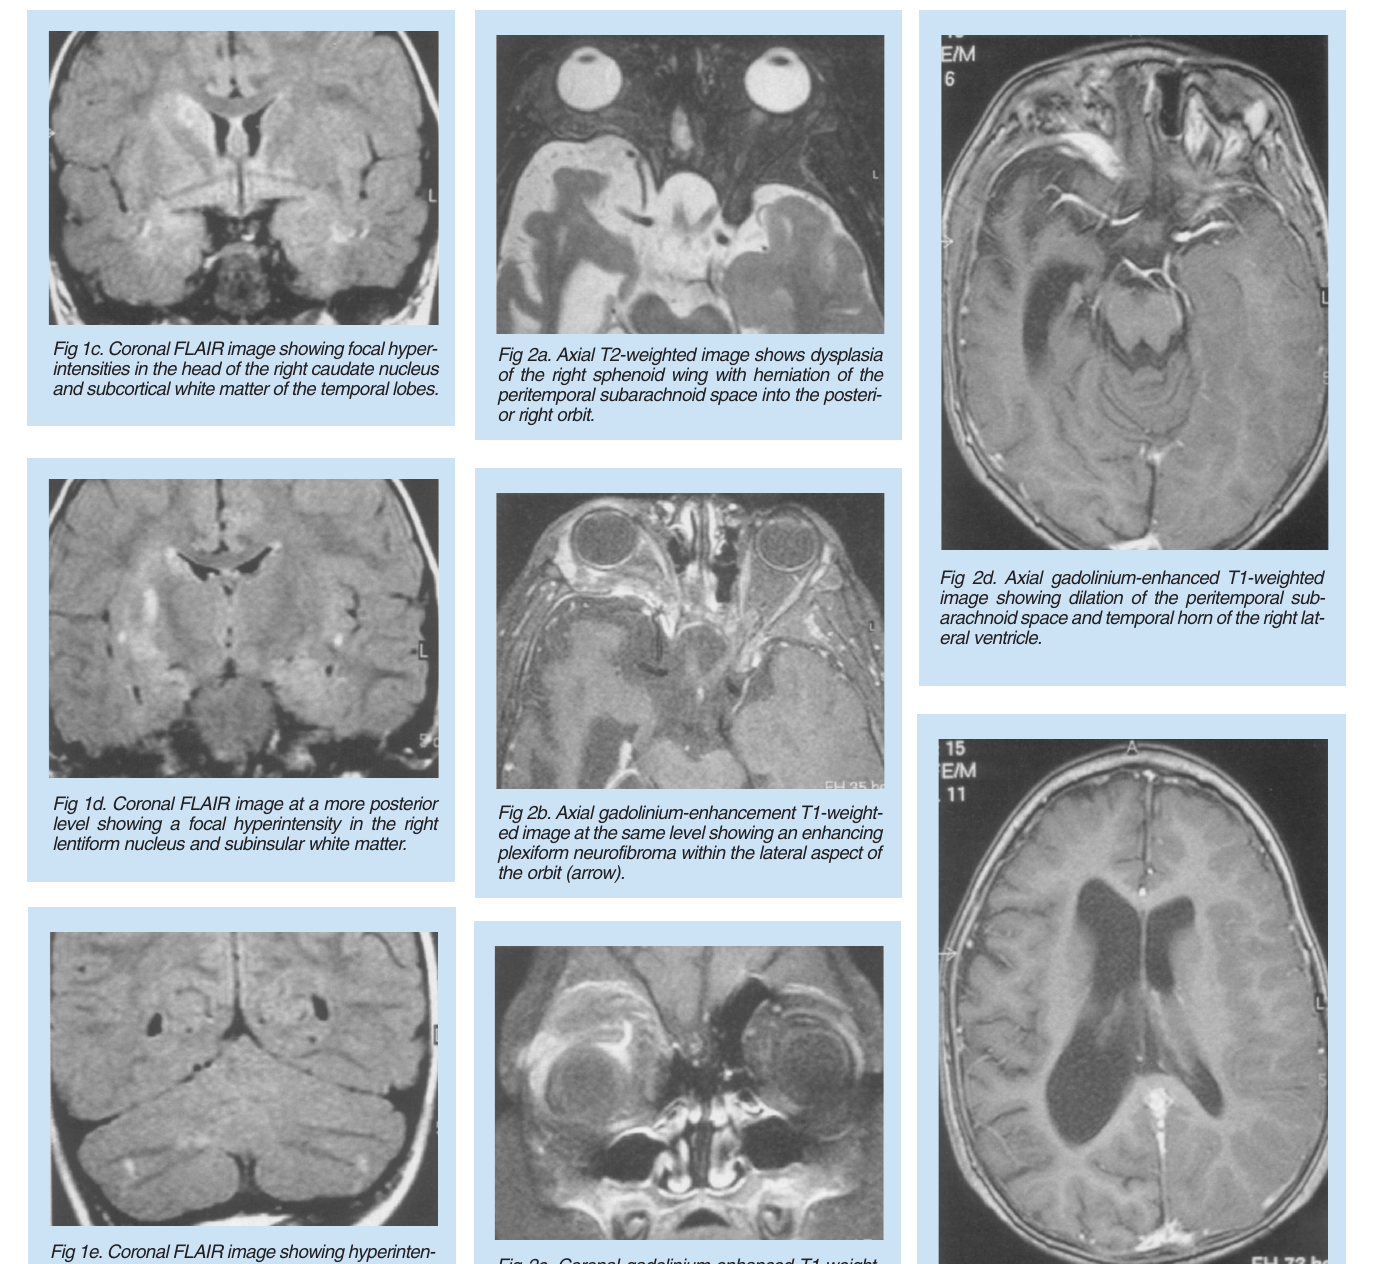
Fig 2c. Coronal gadolinium-enhanced T1-weight- ed image at the same level showing the enhanc- ing plexiform neurofibroma in the lateral aspect of the orbit (arrow).